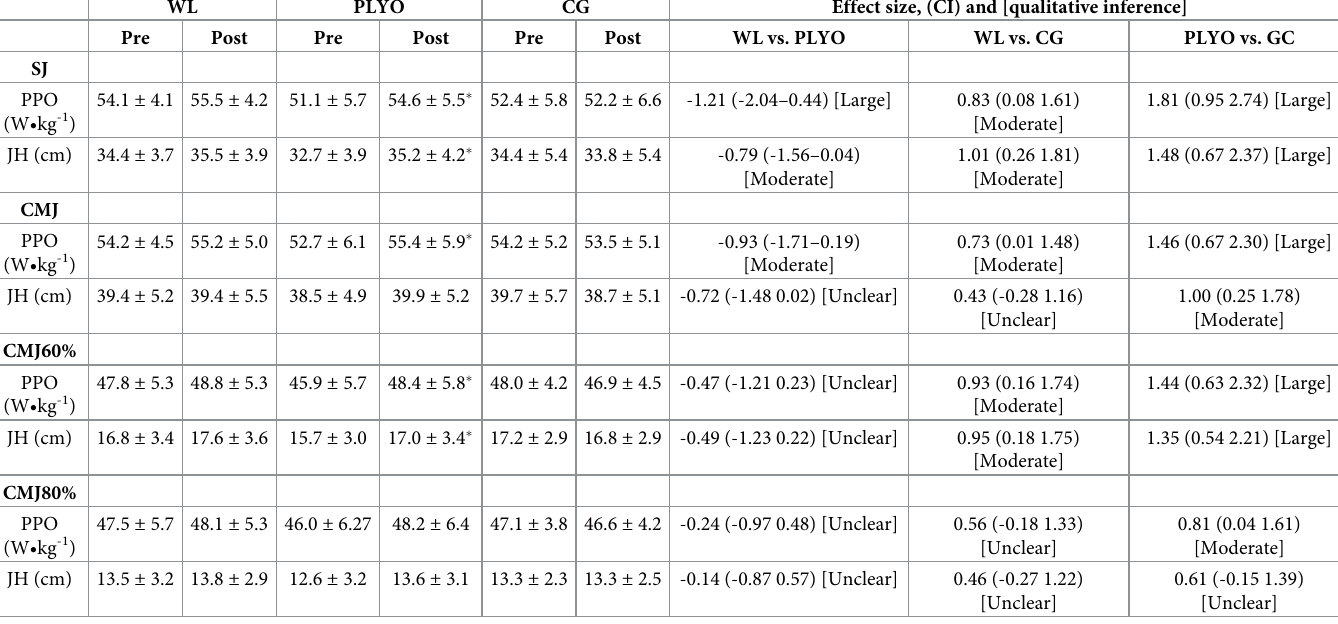
Values pre- and post-training are presented as mean ± standard deviation. CI = 95% confidence interval, SJ = squat jump, CMJ = countermovement jump, CMJ60% = countermovement jump with 60% of body mass, CMJ80% = countermovement jump with 80% of body mass, PPO = peak power output, JH = jump height. � Significant difference from pre-training (p �